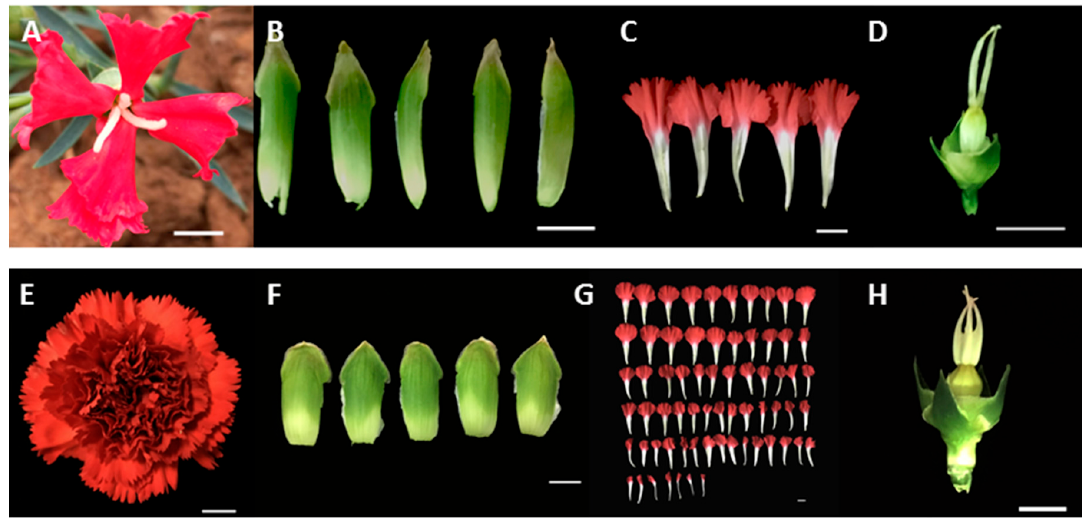
Table 1. Information of the experimental materials.